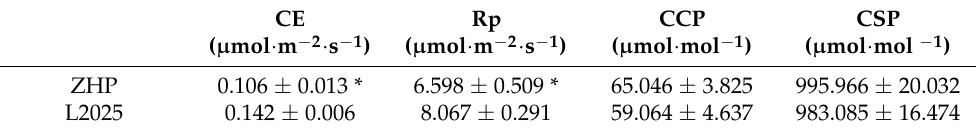
Table 3. Photosynthetic characteristic parameters of CO 2 response curves in ‘L2025’ and ‘ZHP’ seedling